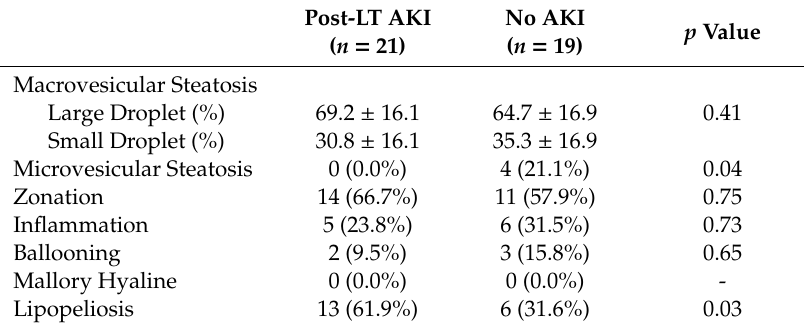
Table 4. Steatotic Liver Graft Biopsy Findings.